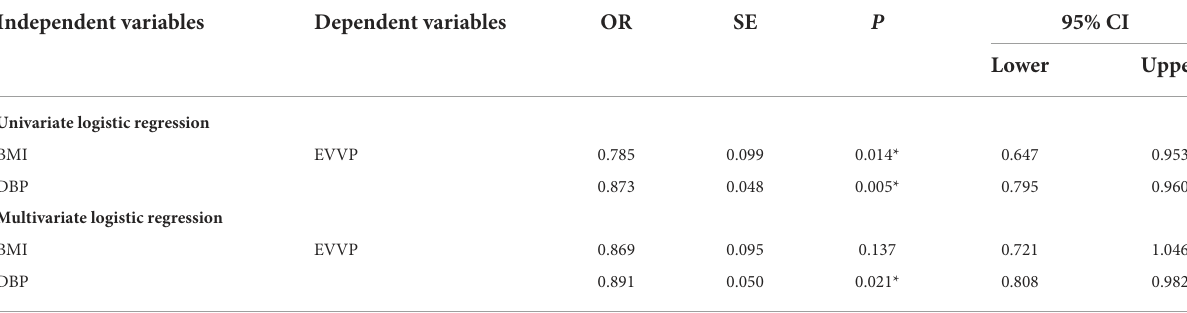
TABLE 3 Univariate logistic regression analysis showed that BMI and DBP negatively correlated with EVVP. Independent variables